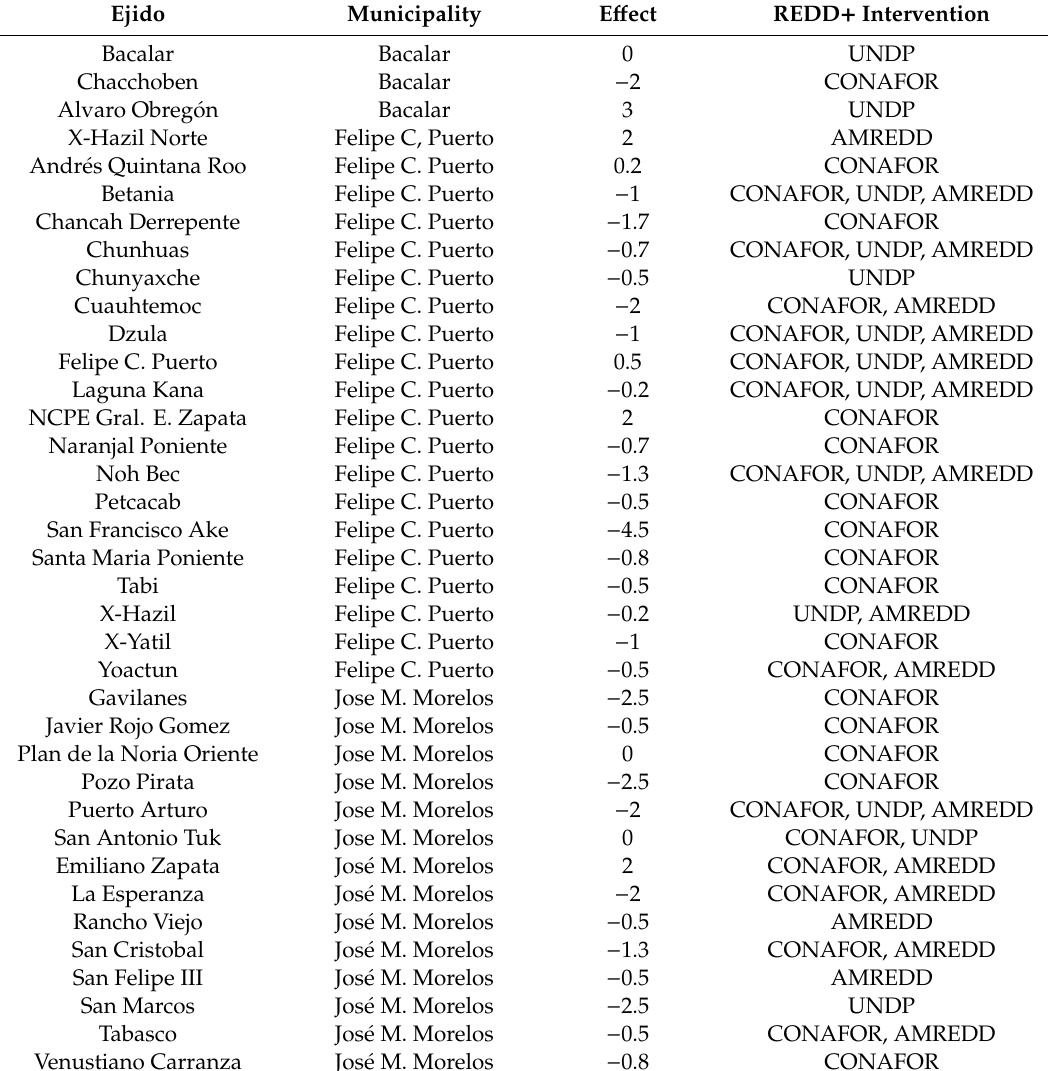
Table A3. Synthetic Control Method (SCM) results of treated unit e ff ects for each REDD + community (ejido) in the state of Quintana Roo (CONAFOR = National Forestry Commission, UNDP = United Nations Development Program, AMREDD = Mexico REDD + Alliance).